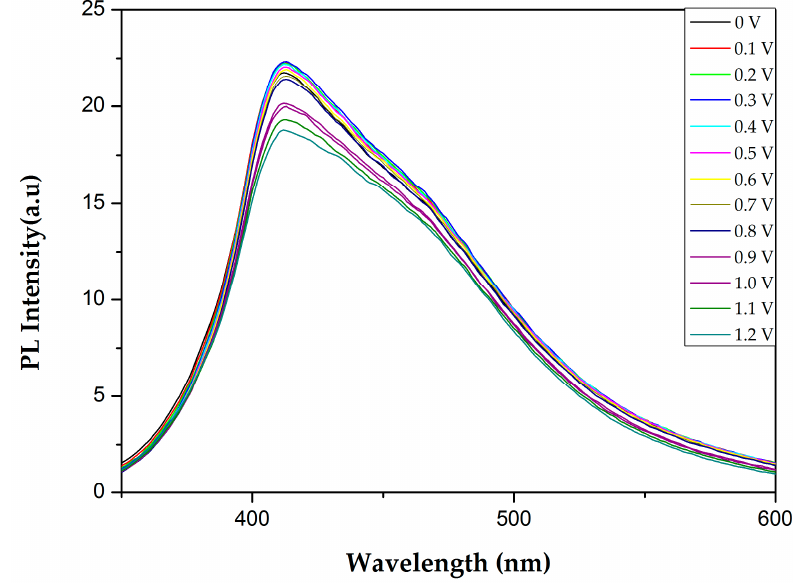
Figure 8. Fluorescence spectra changes of PA–a film upon different applied potentials from 0.0 to 1.2 V.